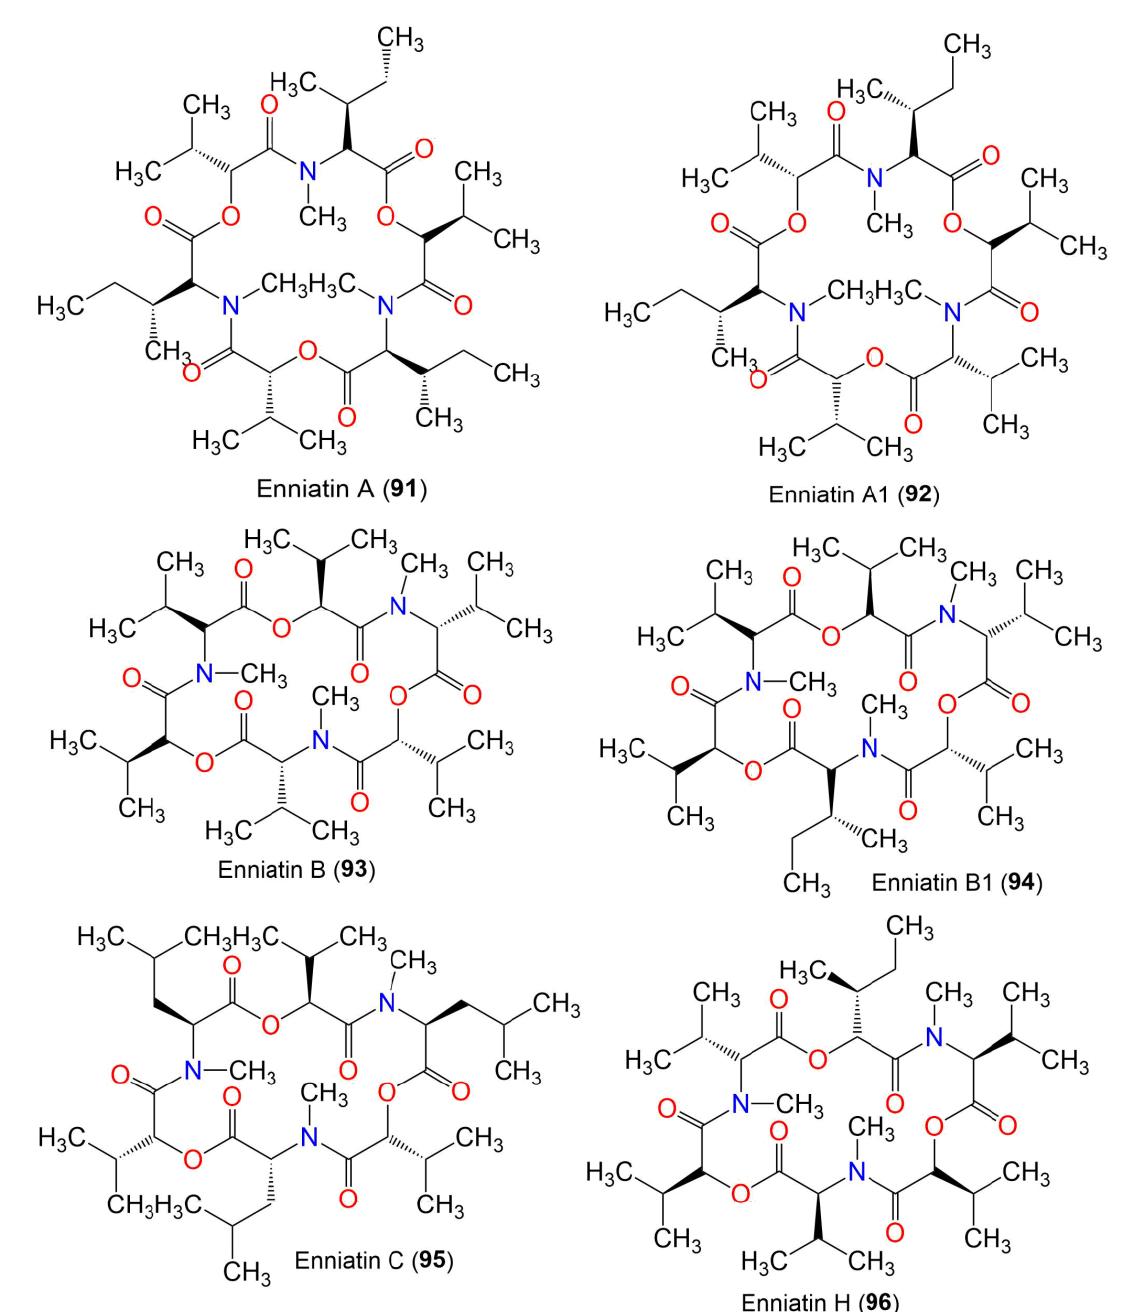
Figure 9. Structures of cyclic depsipeptides ( 91 – 96 ) isolated from F. oxysporum .